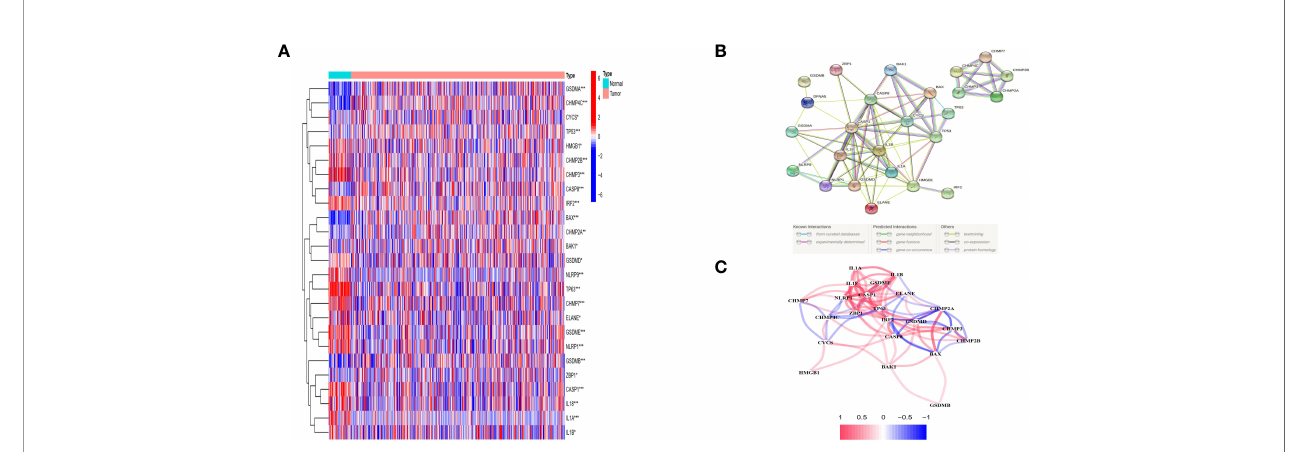
FIGURE 2 | Expressions of the 25 differentially expressed pyroptosis-related genes between tumor and normal and the interactions among them. (A) Heatmap (green: low expression leveI; red; high expression level) of the pyroptosis-related genes between the normal (N, brilliant blue) and the tumour tissues (T.red). P values were showed as: *P < 0.05; **P < 0.01; ***P < 0 001. (B) PPl network showing the interactions of DEPRGs (interaction score= 0.9). (C) The correlation network of DEPRGs (red line: positive correlation: blue line negative correlation. The depth of the colours re fl ects the strength of the relevance).